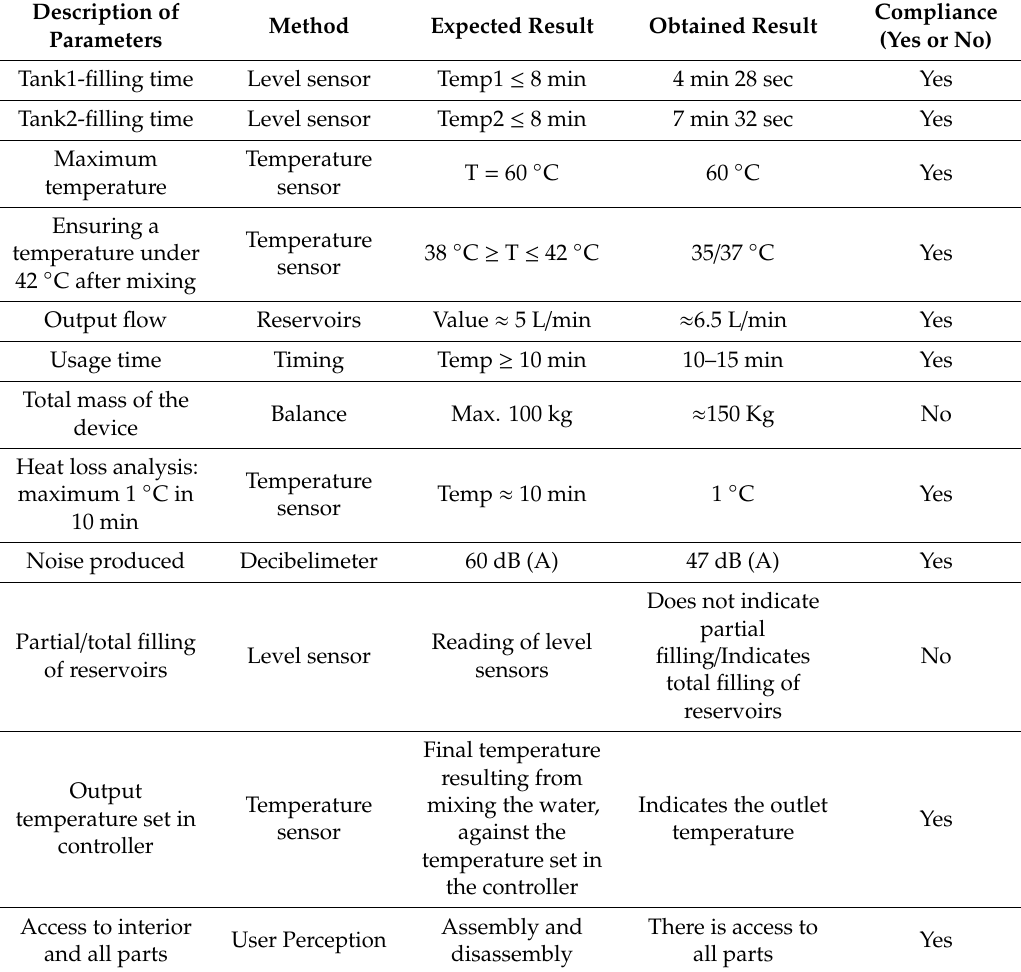
Table 1. Final results of the technical test of the